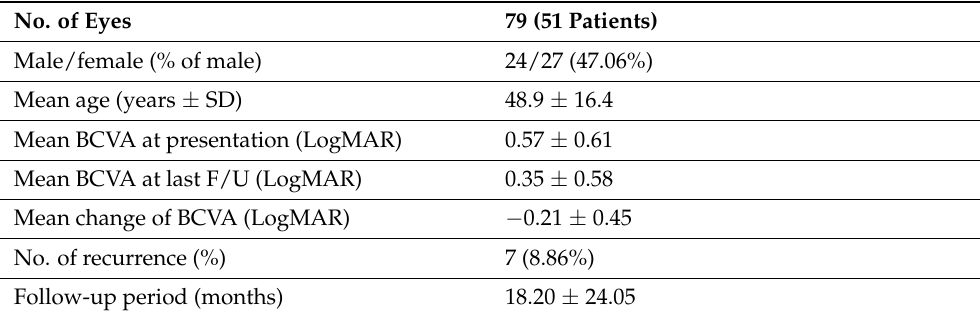
Table 1. The main clinical